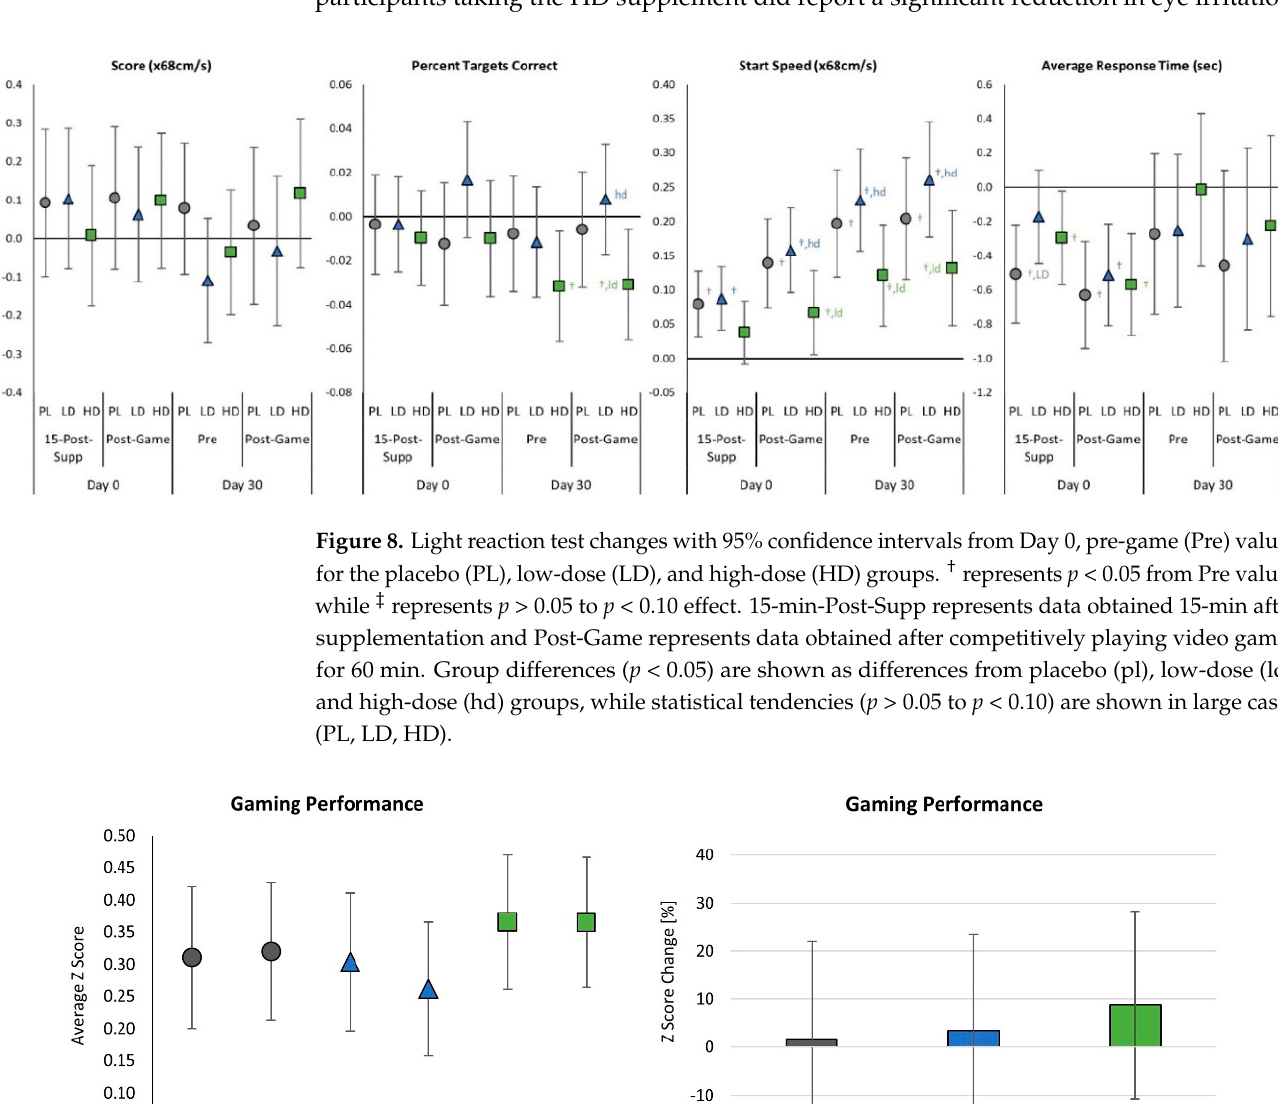
Figure 8. Light reaction test changes with 95% con fi dence intervals from Day 0, pre-game (Pre) values for the placebo (PL), low-dose (LD), and high-dose (HD) groups. † represents p < 0.05 from Pre values while ‡ represents p > 0.05 to p < 0.10 e ff ect. 15-min-Post-Supp represents data obtained 15-min after supplementation and Post-Game represents data obtained after competitively playing video games for 60 min. Group di ff erences ( p < 0.05) are shown as di ff erences from placebo (pl), low-dose (ld), and high-dose (hd) groups, while statistical tendencies ( p > 0.05 to p < 0.10) are shown in large cases (PL, LD, HD).